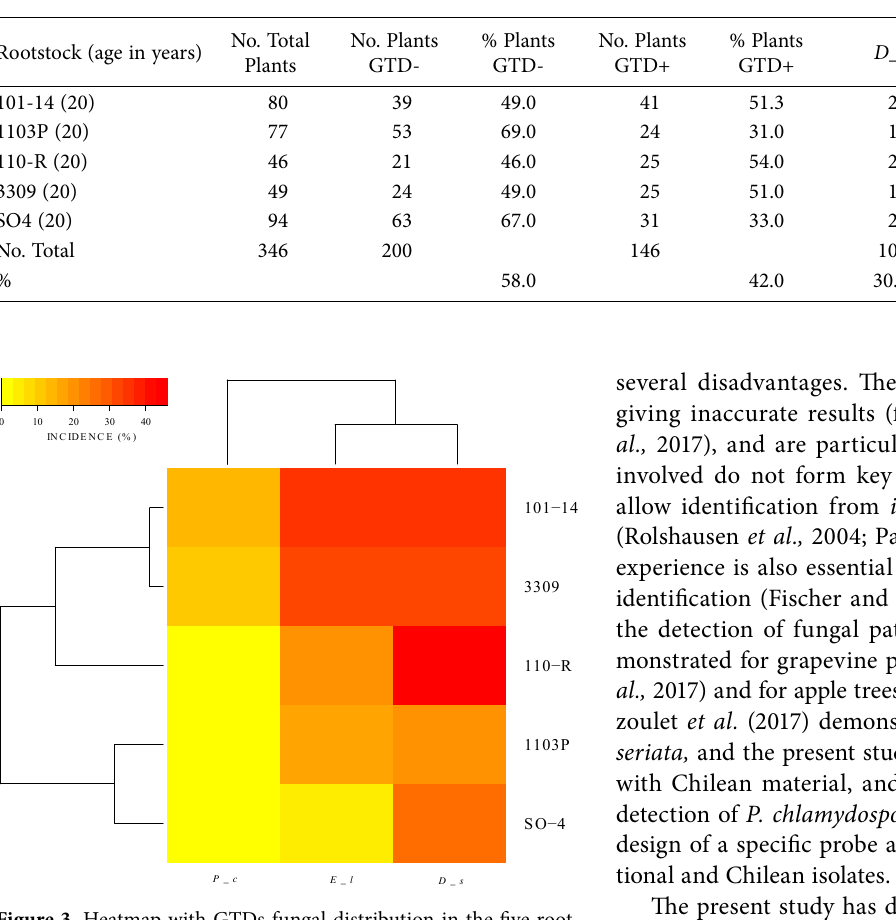
Table 6. Incidence of GTD pathogens in grapevine rootstock plants. NO. = number, GTD- = plants with no GTD fungi, GTD+ = plants with GTD fungi. D_s = Diplodia seriata , E_l = Eutypa lata and P_c = Phaeomoniella chlamydospora . The number below each GTD fungus corresponds to the number of positive plants infected by that fungus.